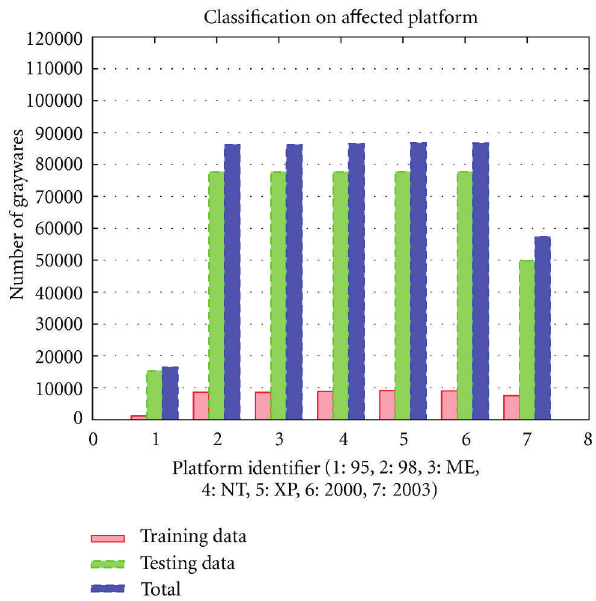
Figure 1: Classification on A ff ected Platform with stemming and stopword elimination.